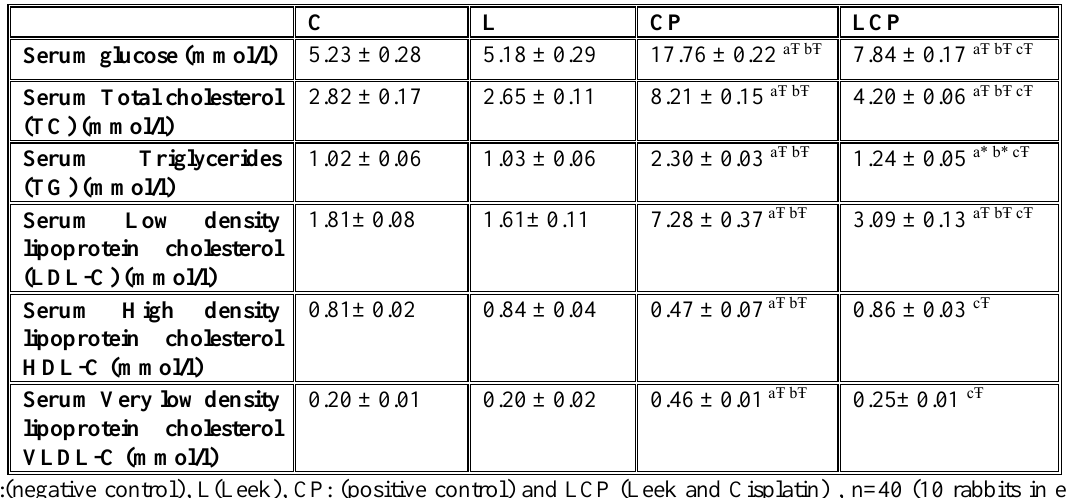
Table 3. The fasting serum glucose and lipid profiles in different groups of rabbits